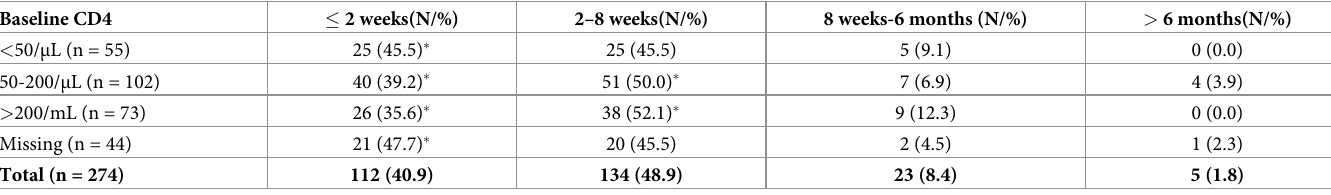
Table 2. Timing of ART initiation after the start of TB treatment (n =